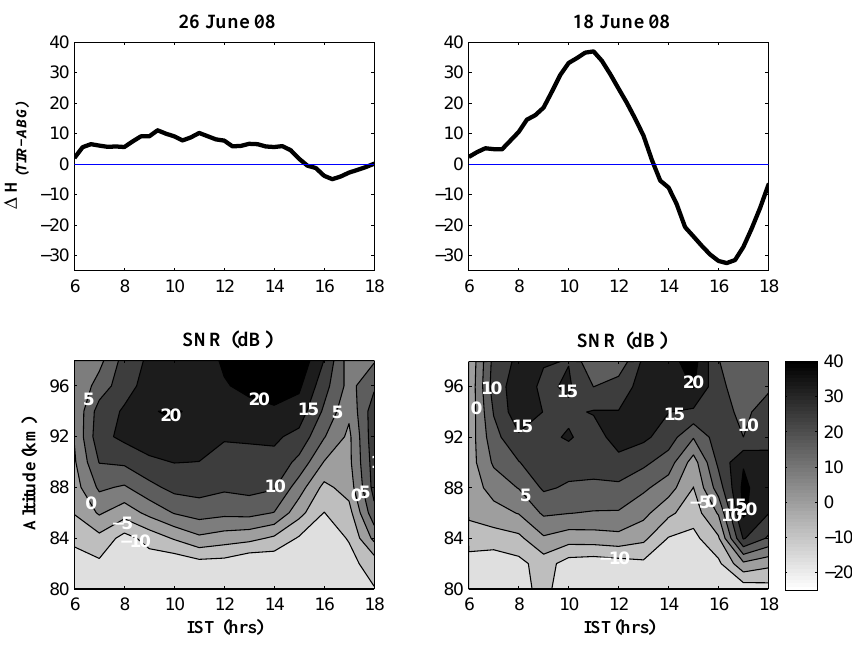
Fig. 1. (top) 1H determined from the ground magnetometer data from Tirunelveli and Alibag and (bottom) daytime SNR in the height range 80–98km on 26 June 2007 (left panels) and 18 June 2007 (right panels).